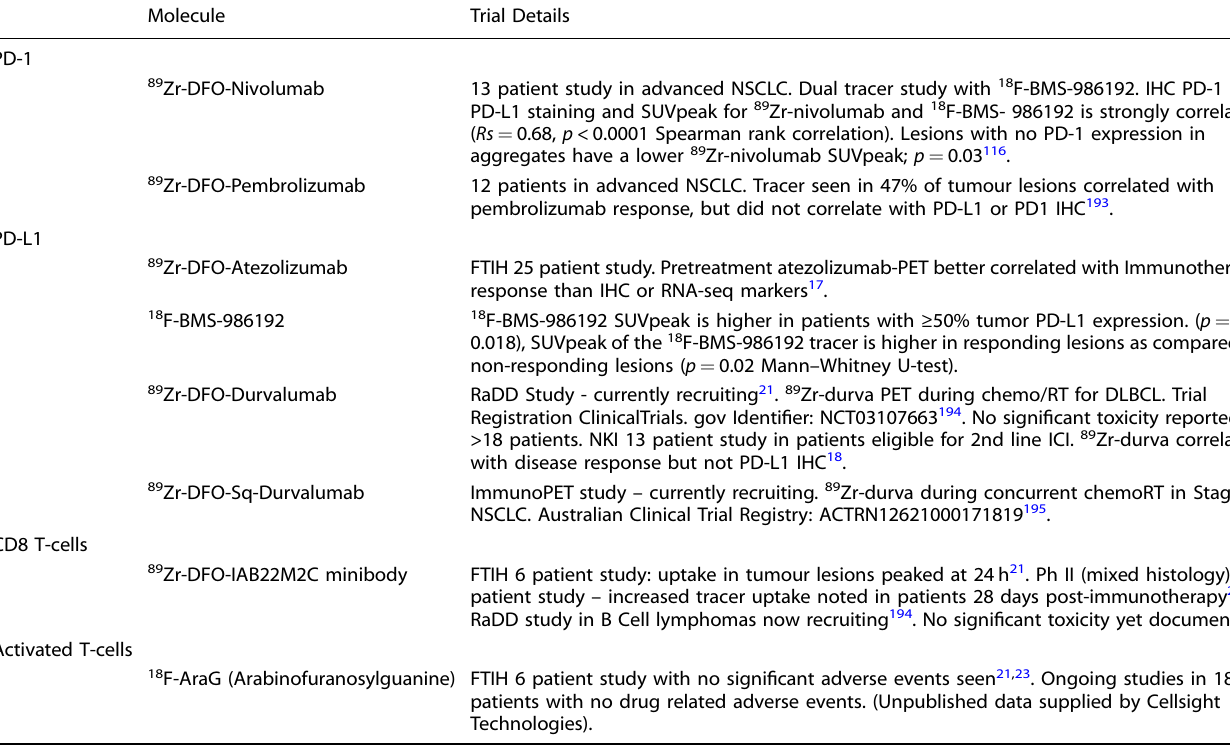
Table 2. Selected Studies of PET Tracers of CD8, PD-1 and PD-L1 in Human Clinical Trials. Molecule Trial Details PD-1